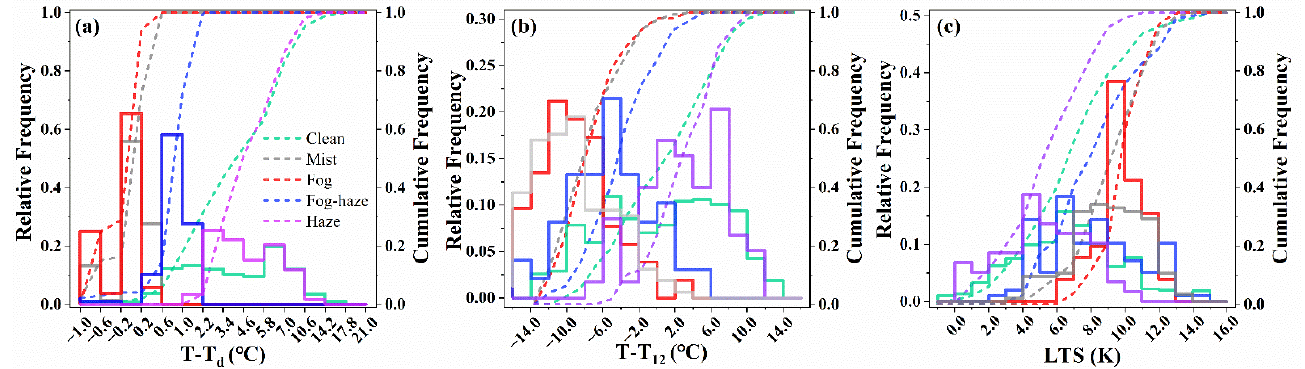
Figure 3. The probability distribution functions of ( a ) air ‐ dewpoint temperature difference (T ‐ T d ), ( b ) 12 h temperature gradient (T ‐ T 12 ), and ( c ) low tropospheric stability (LTS, up to 850 hPa). The solid line is the relative frequency, and the dashed line is the cumulative frequency.